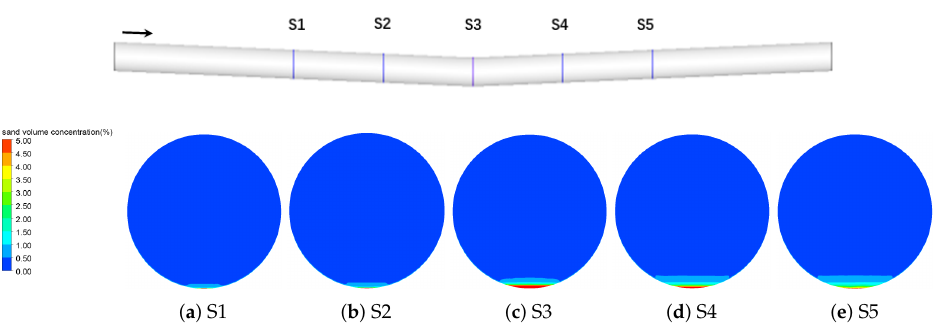
Figure 12. Sand volume concentration contours at different cross-sections of horizontal pipe (inflow velocity = 0.4 m/s).